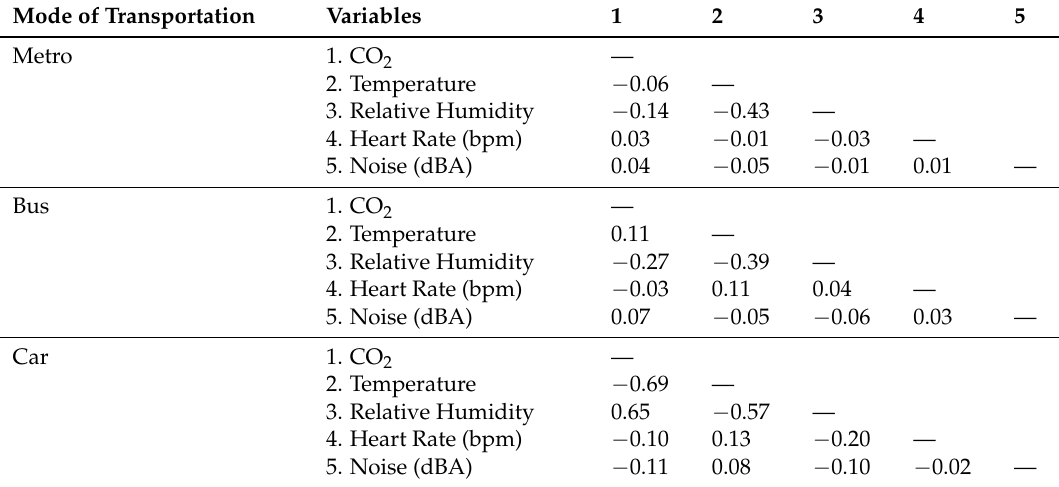
Table 3. Correlation table for all modes of transportation (all datasets upsampled to N = 136,212). Mode of Transportation Metro